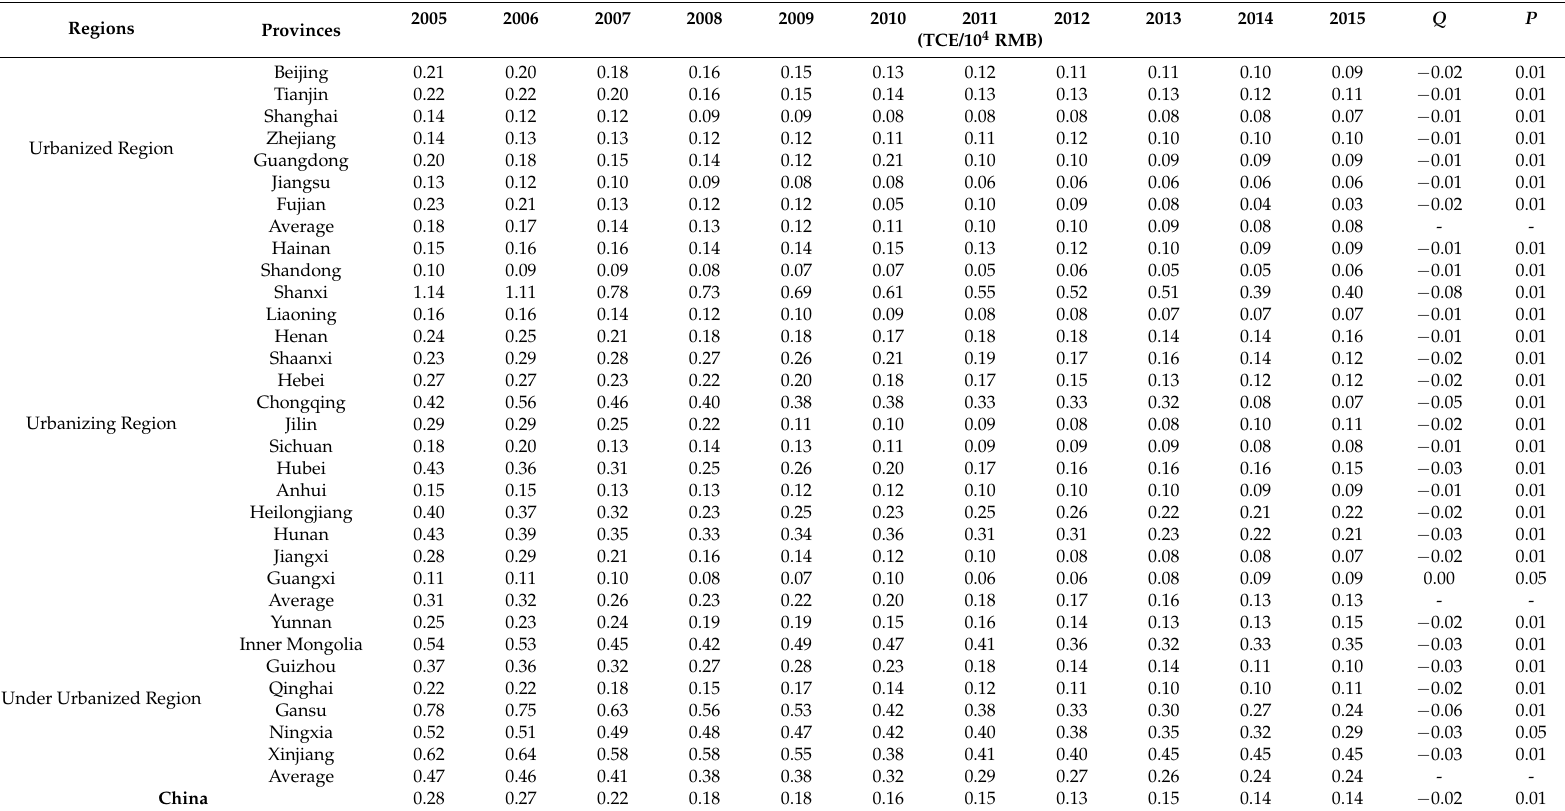
Table A5. China’s energy consumption intensity (ECI), Sen’s slope (Q), and significance level (P) of primary industry (PI) at provincial and national levels between 2005 and 2015.